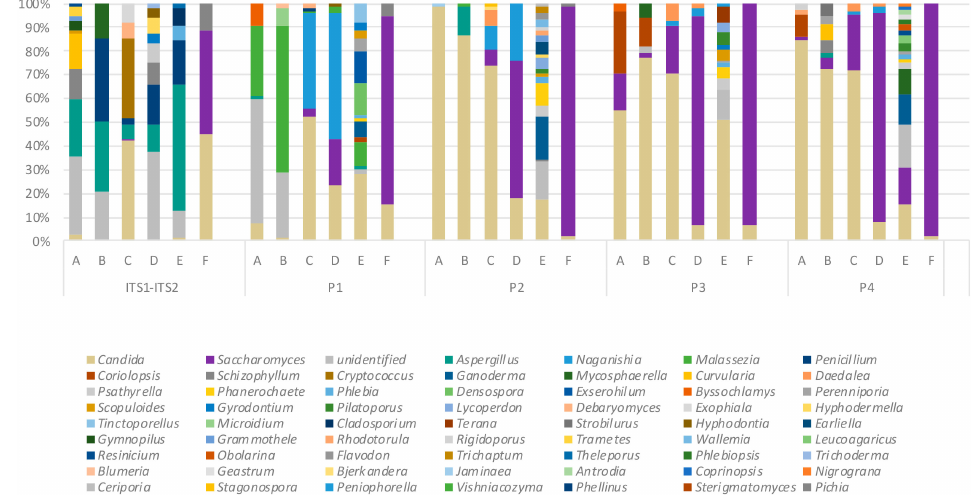
Figure 5. Analysis of sputum mycobiome profiles obtained by alternative sequencing approaches including dual ITS1-ITS2 targeted amplicon shotgun sequencing and ITS1 or ITS2 targeting techniques applied in this study. Colored bars represent relative abundance of the indicated taxa. DNA derived from sputum samples from bronchiectasis patients (A–F) served as a DNA